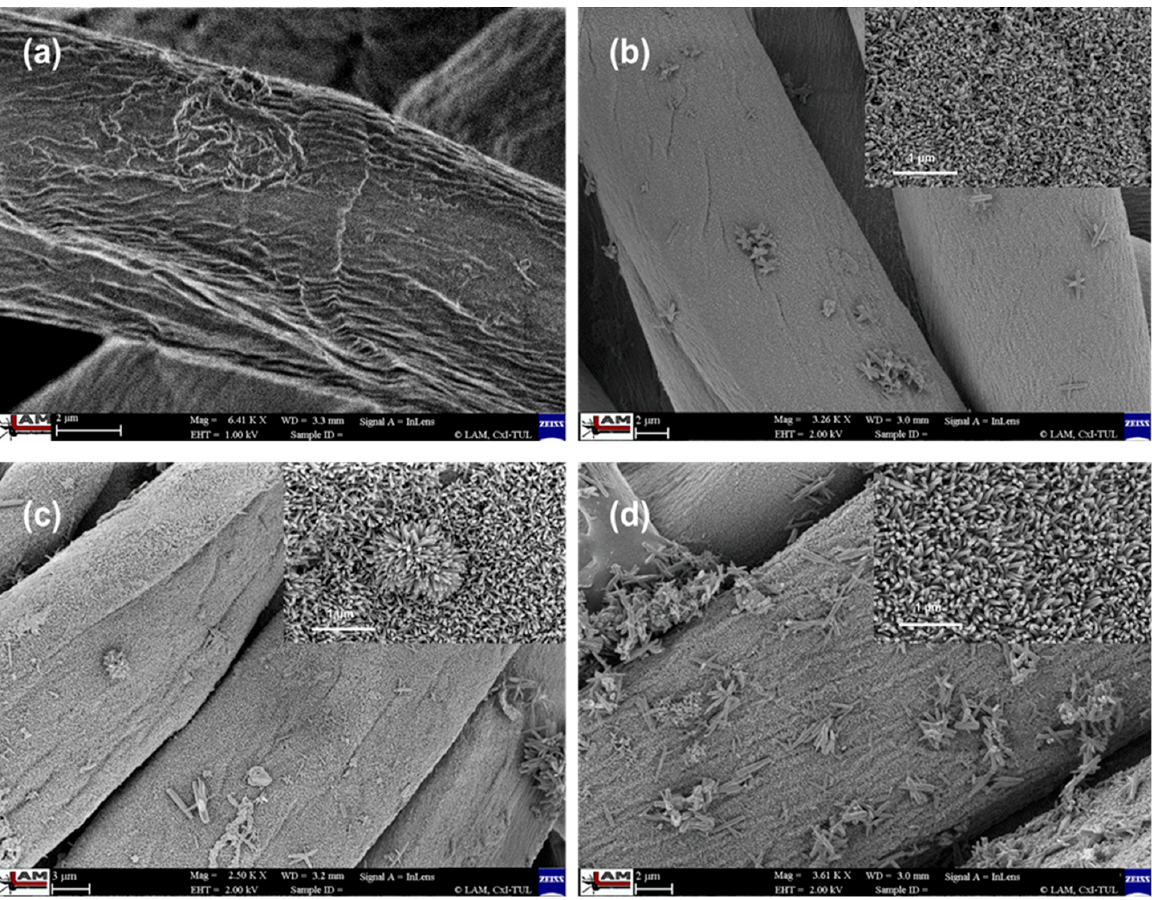
Figure 2. SEM images of the zinc-oxide-nanorod-grown cotton fabric for various microwave irradiation times: ( a ) 0 min, ( b ) 4 min, ( c ) 8 min, and ( d ) 12 min. The insets are highly magnified corresponding images.